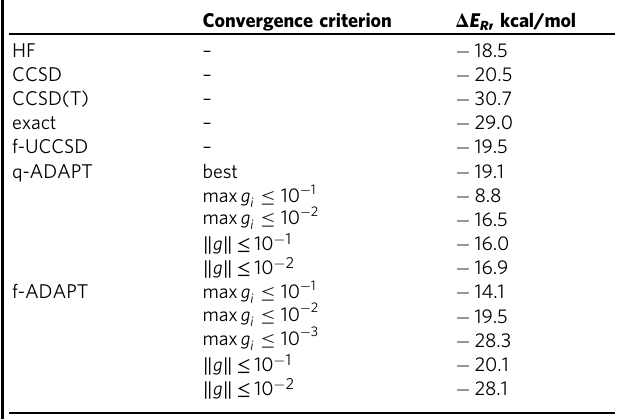
Table 2 Electronic energy of CO oxidation reaction computed with the studied classical and quantum methods. Convergence